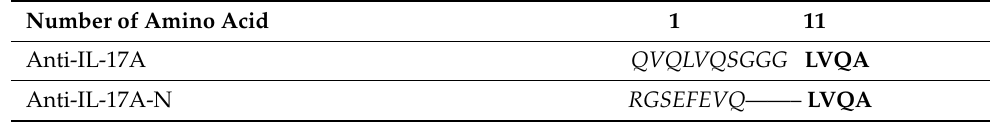
Table 3. Anti-IL-17A and anti-IL-17A-N amino acid sequence alignment in the N-terminal region. Amino acids of the altered region are shown in italic, matching amino acids are in bold.